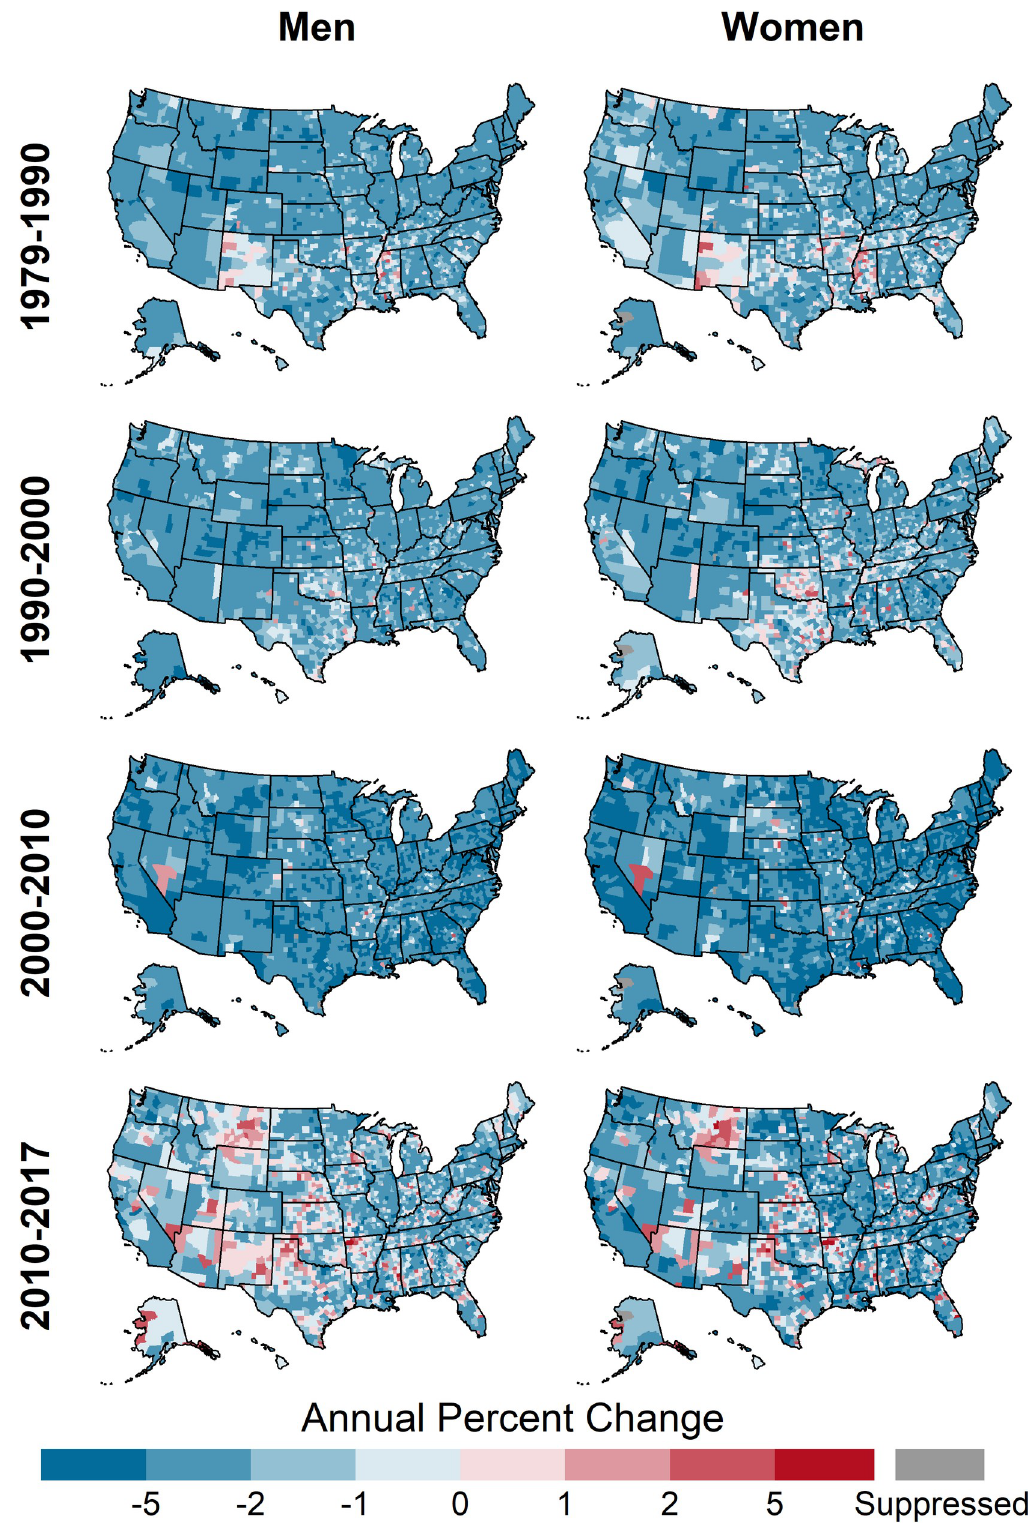
Fig 9. Annual percent change in county-level CHD death rates by year and gender, ages 35 and older, United States, 1979– 2017.